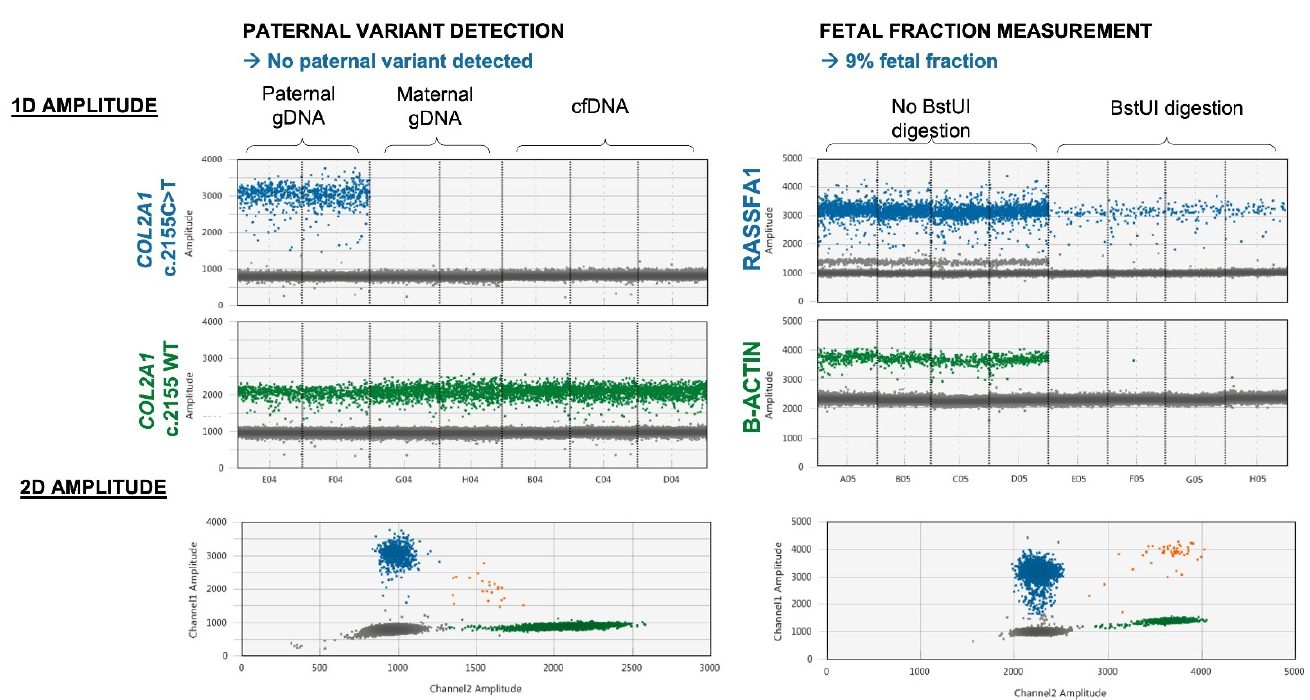
Figure 4. Noninvasive prenatal diagnosis by paternal variant exclusion: results of droplet digital PCR amplification. The presence of fetal DNA in maternal plasma was confirmed through the detection of RASSF1A-positive droplets after BstUI digestion. Parental genomic DNA (gDNA) was tested concomitantly with maternal plasma cell-free DNA (cfDNA) as positive and negative controls. The calculated probability for the twins to be monozygotic twins was 99.976%. We performed multiplex PCR amplification for the COL2A1 gene (eight polymorphic DNA sequences) and compared the results to those of the transferred embryo. The results were identical between the twins, as well as between the twins and the Day 5 trans- ferred